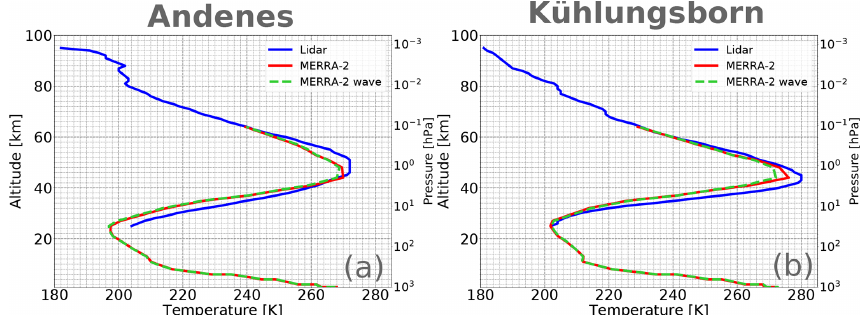
Figure 4. Mean vertical STE profiles at Andenes (a) and Kühlungsborn (b) derived from lidar observations (blue), MERRA-2 (red) and MERRA-2 reconstructed for wave 123 (green,